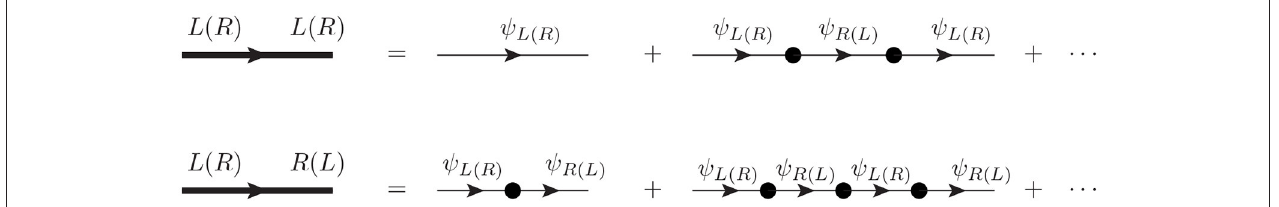
FIGURE 3 | Diagrammatic interpretation of the dressed propagators (thick lines) for the same and opposite chiralities as an infinite series of successive mass insertions (black dots) between two massless propagators (thin